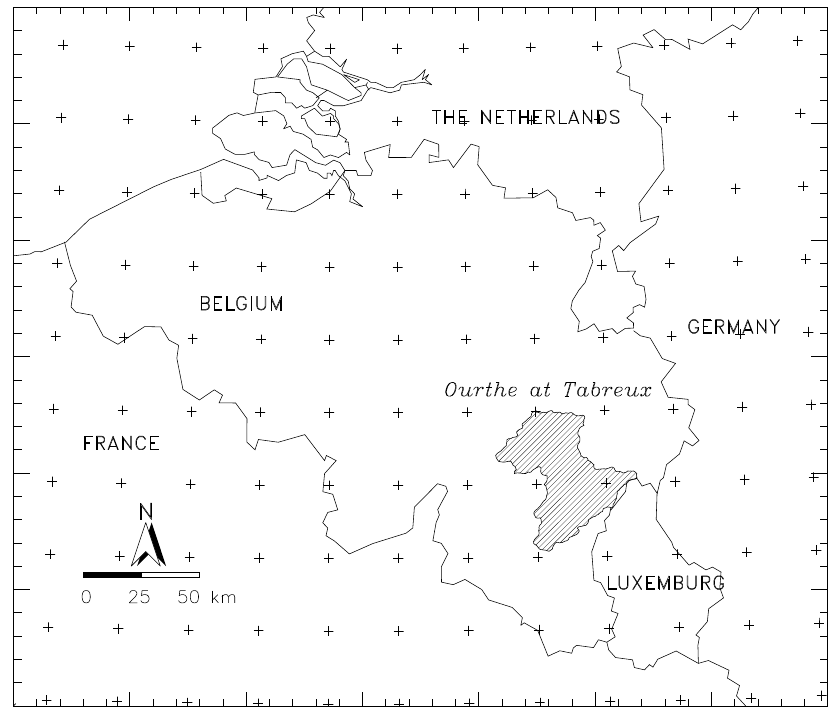
Figure 2. Map of the Ourthe catchment. Also shown are the Ensemble Prediction System (ENS) N320 grid points.